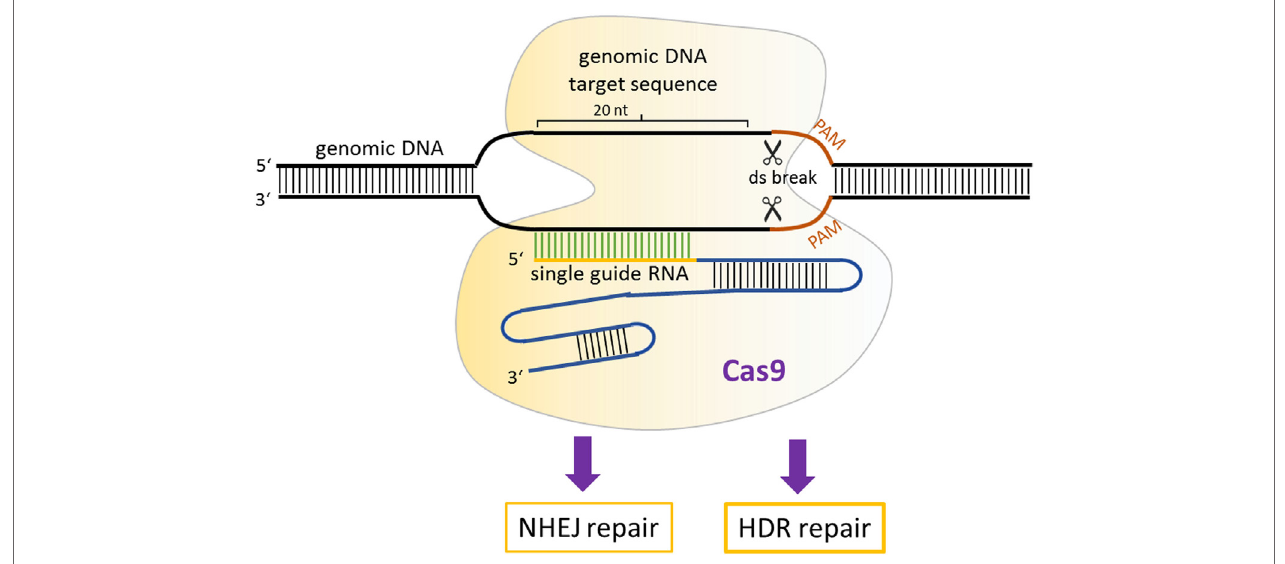
FiGURe 3 | Mechanism of CRISPR/Cas9 gene modulation. A single guide RNA directs Cas9 nuclease to a genomic locus, where it cuts the target sequence in the presence of protospacer-adjacent motif. The resulting double-stranded breaks stimulates DNA repair, which can occur via non-homologous end-joining or homology-directed repair-mediated